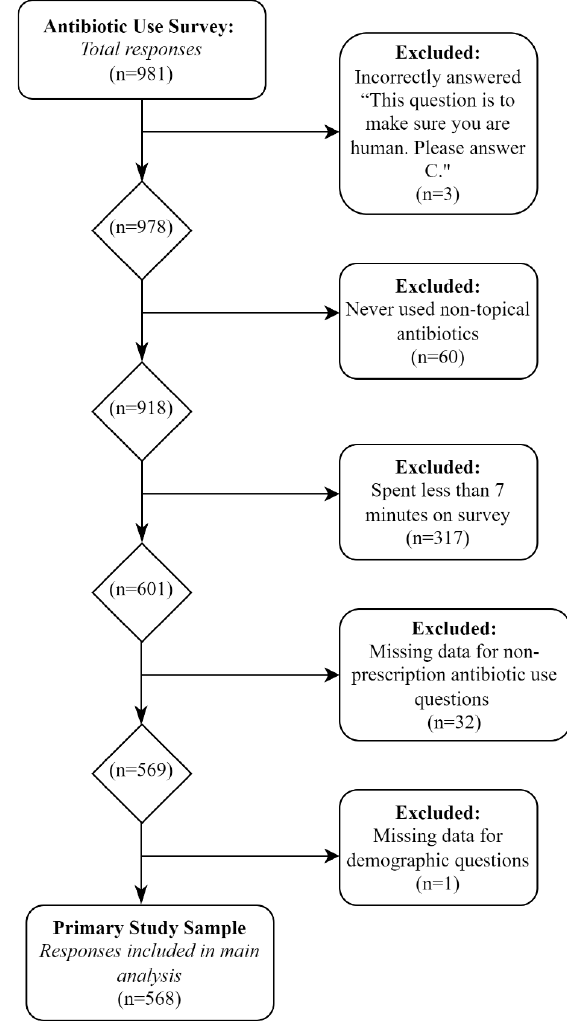
Figure 1. Inclusion of participants for statistical analysis.